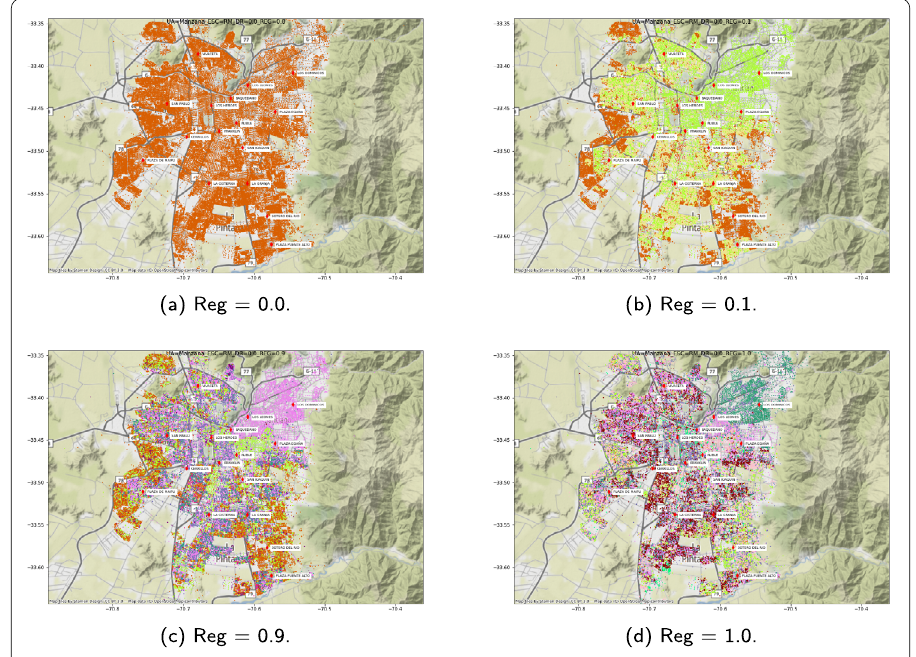
Figure 3 Collapsed regularizer calibration. As the presence of the regularizer increases in the objective function, more local structures appear. The best configuration is obtained with reg = 1.0, where the